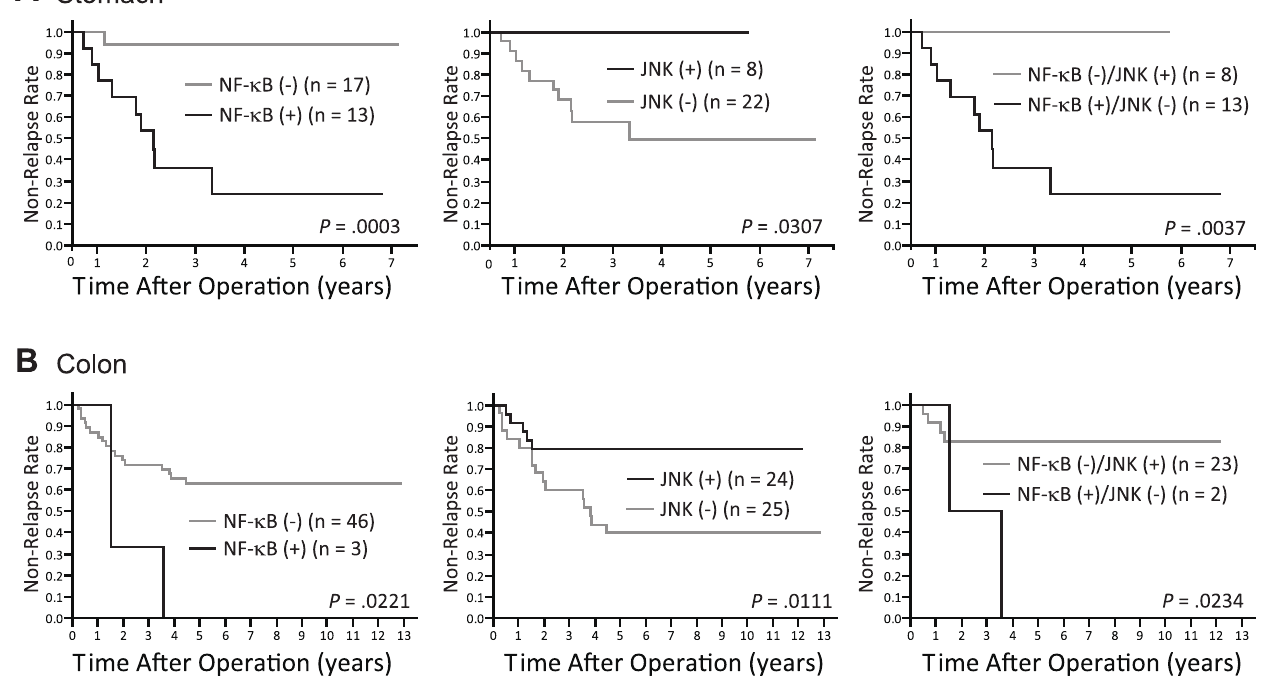
Figure 2. Time-to-relapse (TTR) rates on the basis of NF- k B and JNK protein expression in gastric and colon carcinomas.